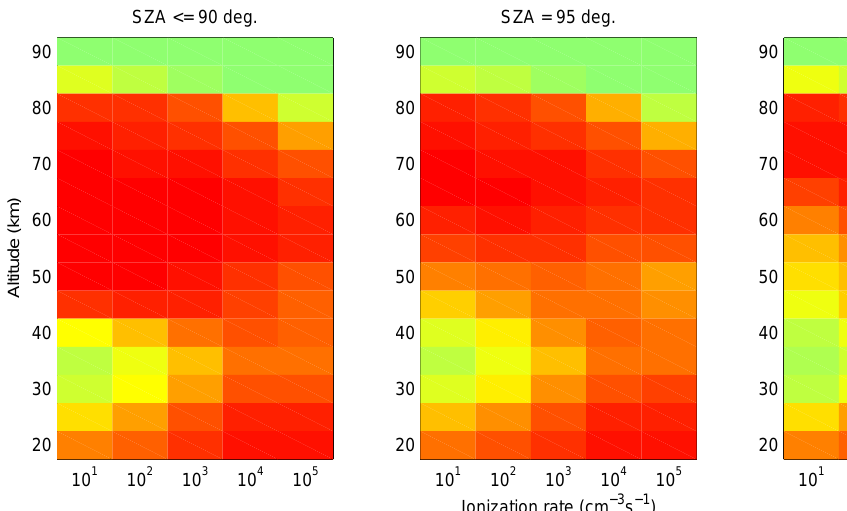
Fig. A19. P H /Q for October